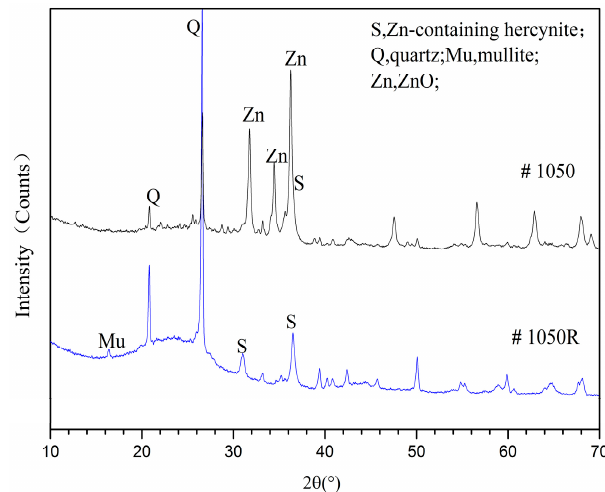
Figure 5. XRD patterns for 1050 °C DTF ash (black) of SH light coal and its boiling acid separation residue (blue).